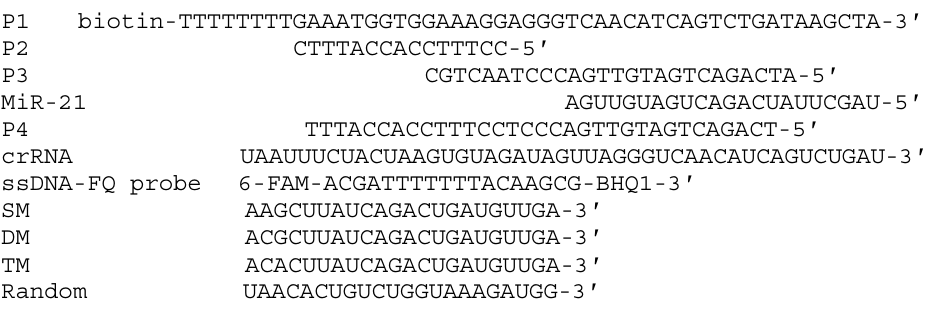
Figure 1. Sequences of nucleic acid used in the experiment.